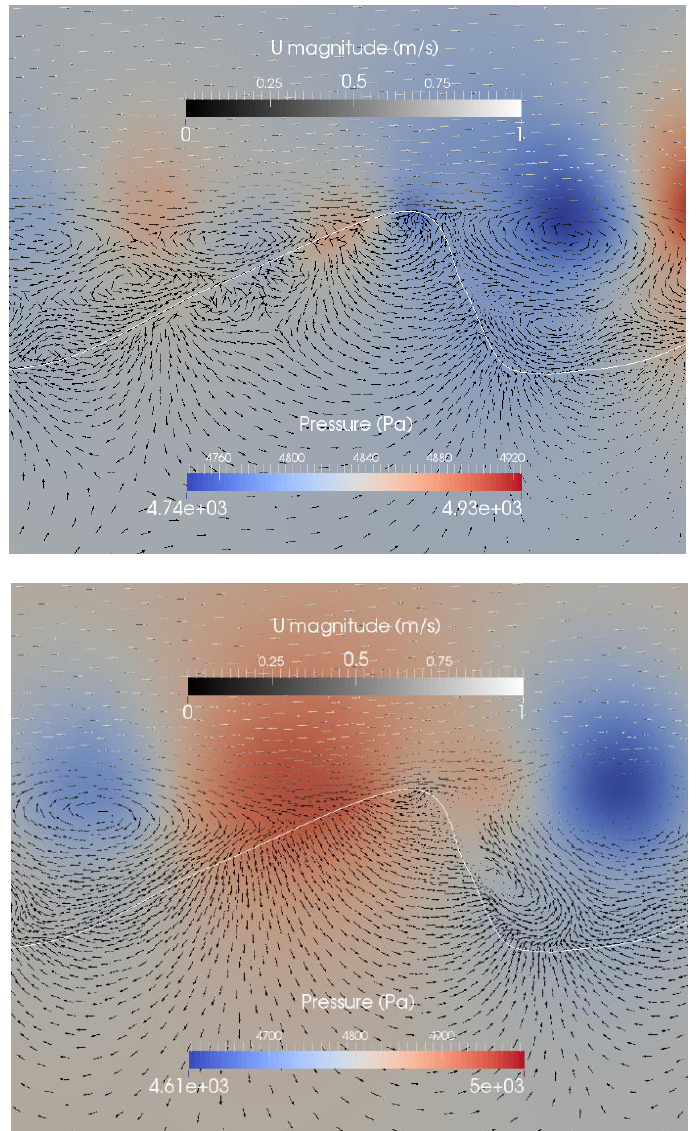
Figure 9. Pressure distribution and velocity vectors at a sandy (top) and gravel (bottom) ripple for case 3 (Table 1). The white line indicates the sediment-water interface. The colors indicate the pressure distribution. Please note that the scaling is different in the right and the left panel. The arrows indicate flow directions of the surface and the subsurface flow. To visualize the intensity of the flow U a grey is used.